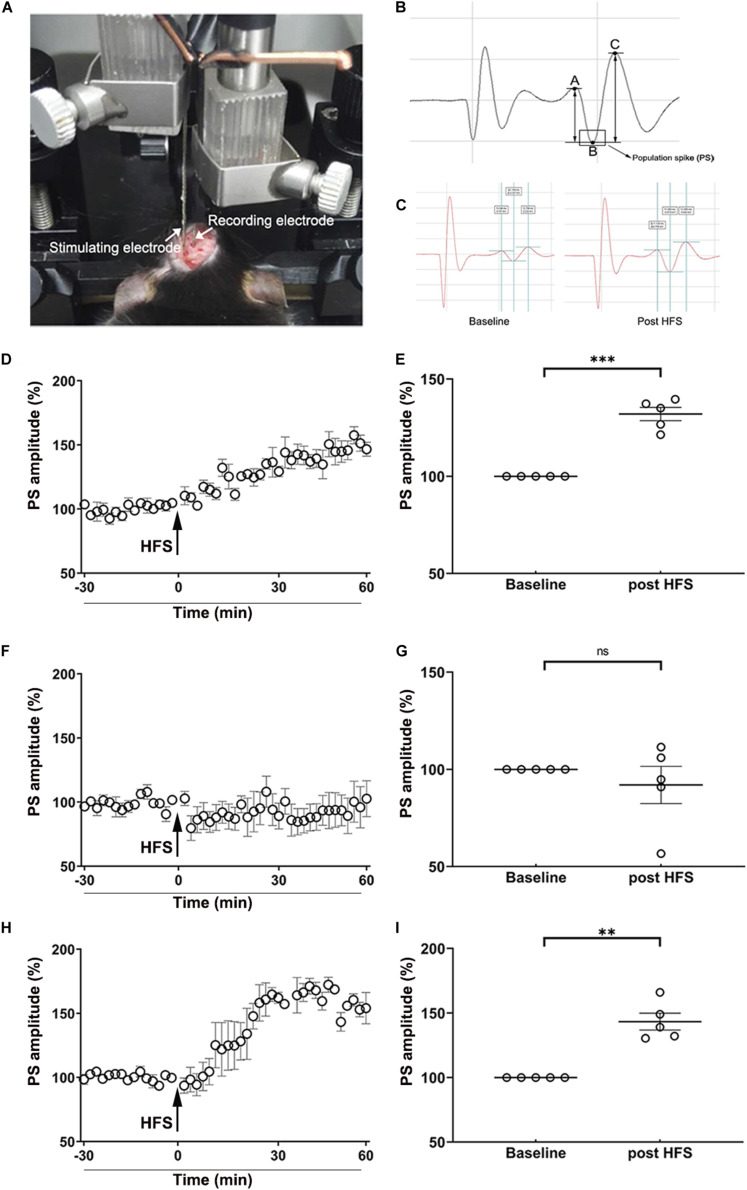
MA-induced inhibition of LTP in vivo is reversed by TUDCA pre-treatment. (A) The position of stimulating electrodes and recording electrodes in the electrophysiological experiments. (B) A typical form of the population spike (PS) was consisted of a descending branch (AB) and an ascending branch (BC). The amplitude of PS was calculated by the average of the potential difference of AB and BC. (C) A typical enhancement of PS amplitude post-HFS, compared with the baseline. (D,E) The HFS induced a significant increase of the PS amplitude in the Saline group. (F,G) When mice were treated with MA, there was no difference in the PS amplitude post-HFS in comparison with the baseline. (H,I) When mice were pretreated with TUDCA, the HFS induced a prominent enhancement of the PS amplitude. **p < 0.01, ***p < 0.001 vs. the baseline, ns indicated p > 0.05. Data was presented as the mean ± SEM, n = 5 per group.